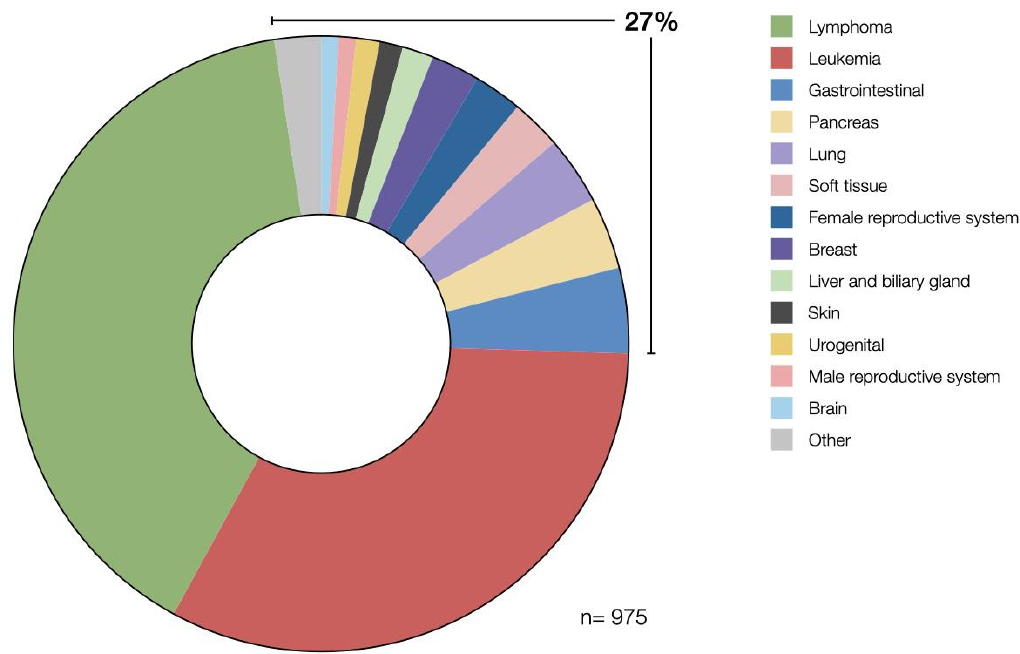
Figure 3. A growing number of studies registered on clinicaltrials.gov is focusing on solid tumors. The majority of studies combined 73% are still targeting various types of lymphomas and leukemia. Others include several studies on malignancies of the following tissues: adrenal gland, salivary gland, thyroid, eye, head and neck, and germ